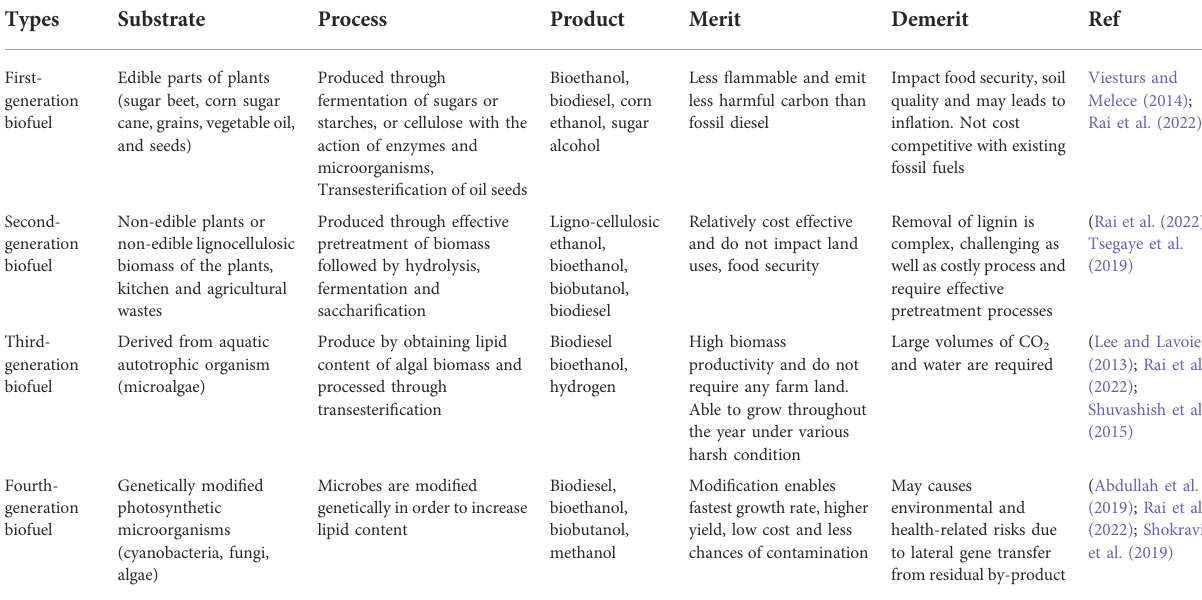
TABLE 3 Comparison of fi rst, second, third, and fourth generation